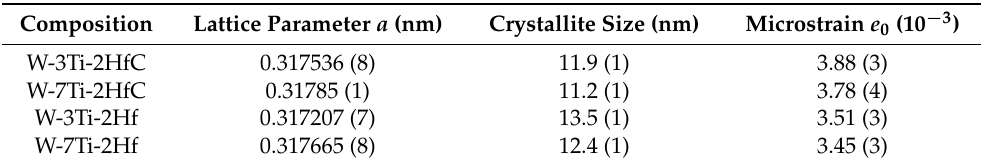
Table 2. Results of Rietveld refinement fit for tungsten matrix phase in mechanically alloyed powders for 40 h. Fit errors of the last digit are given in parentheses.